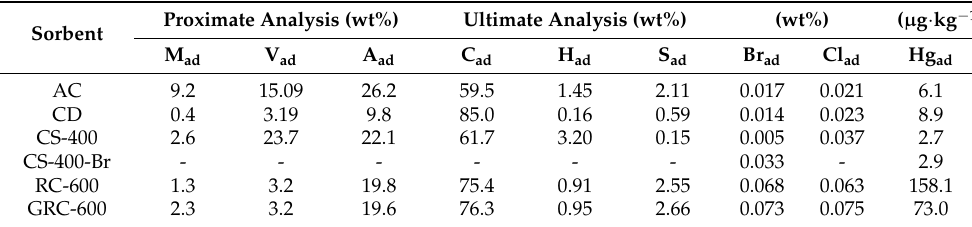
Table 2. Properties of the analyzed